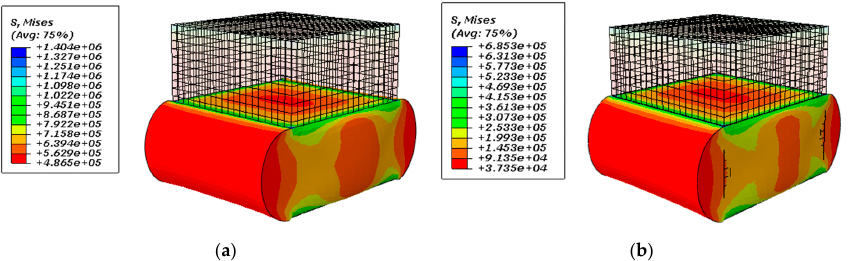
Figure 11. Stress distribution of PU SMP foams at different temperatures at the end of loading. The stress contours are related to the stress-strain results of the models illustrated in Figure 10 for ( a ) T = 20 ◦ C, and ( b ) T = 70 ◦ C.